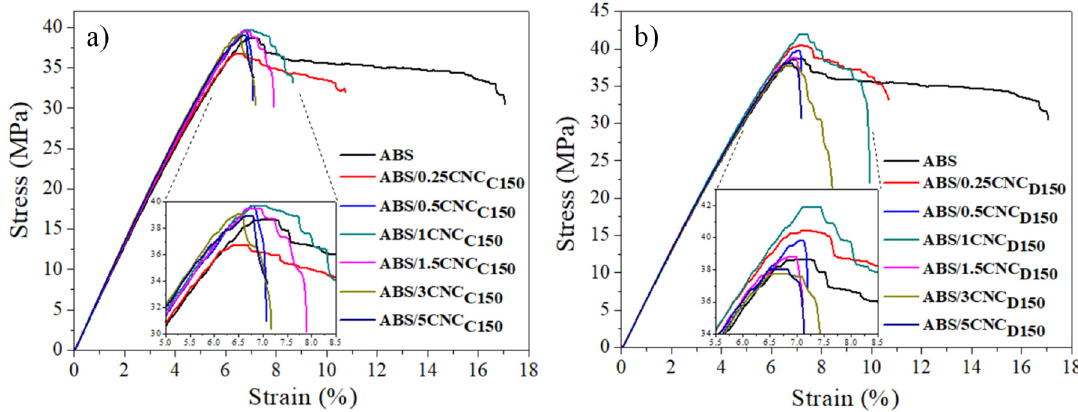
Figure 8. Stress versus strain curves of ABS/150W ε -caprolactone modified CNC nanocomposites ( a ) and ABS/150 W δ -decalactone-modified CNC nanocomposites ( b ).